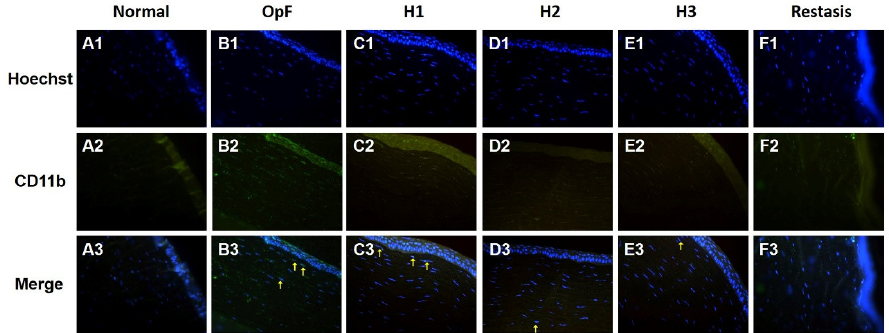
Figure 7. Representative images of immunofluorescence staining of corneal sections on day 42 showing CD11b staining (green, A2 – F2 ), with Hoechst 33342 nuclear counterstaining (blue, A1 – F1 ) and merged image ( A3 – F3 ) as an indicator of corneal inflammation in the normal ( A ), Optive Fusion ® ( B ), H1 ( C ), H2 ( D ), H3 ( E ), and Restasis ® ( F ) groups. HA-nimesulide conjugates exhibited a similar anti-inflammatory effect as Restasis ® .